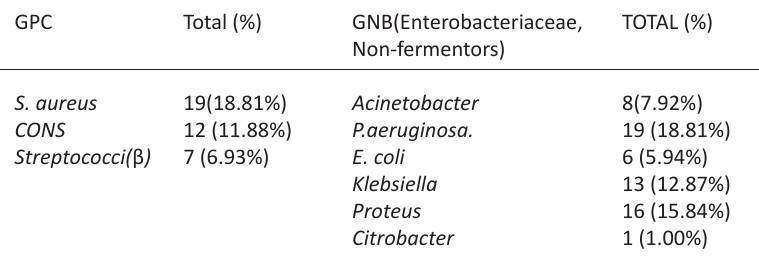
Table 2. Table showing the different types of Bacterial growth GPC Total